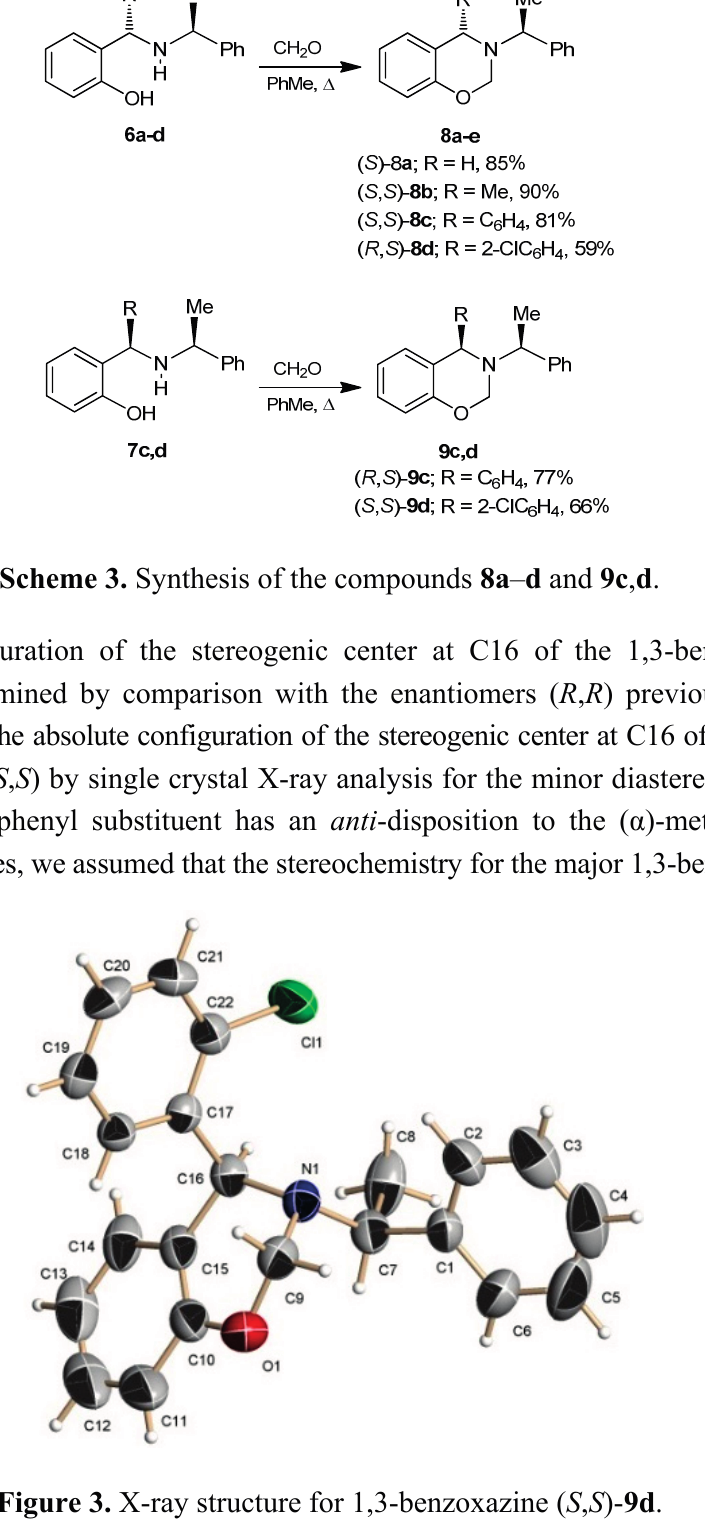
Figure 3. X-ray structure for 1,3-benzoxazine ( S , S )- 9d